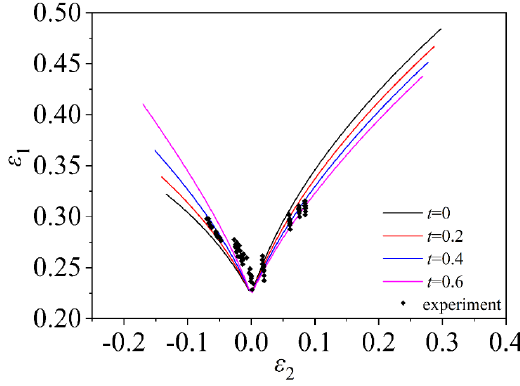
Figure 27. FLD of material 5754O is obtained based on VOCE constitutive equation and MMFC instability